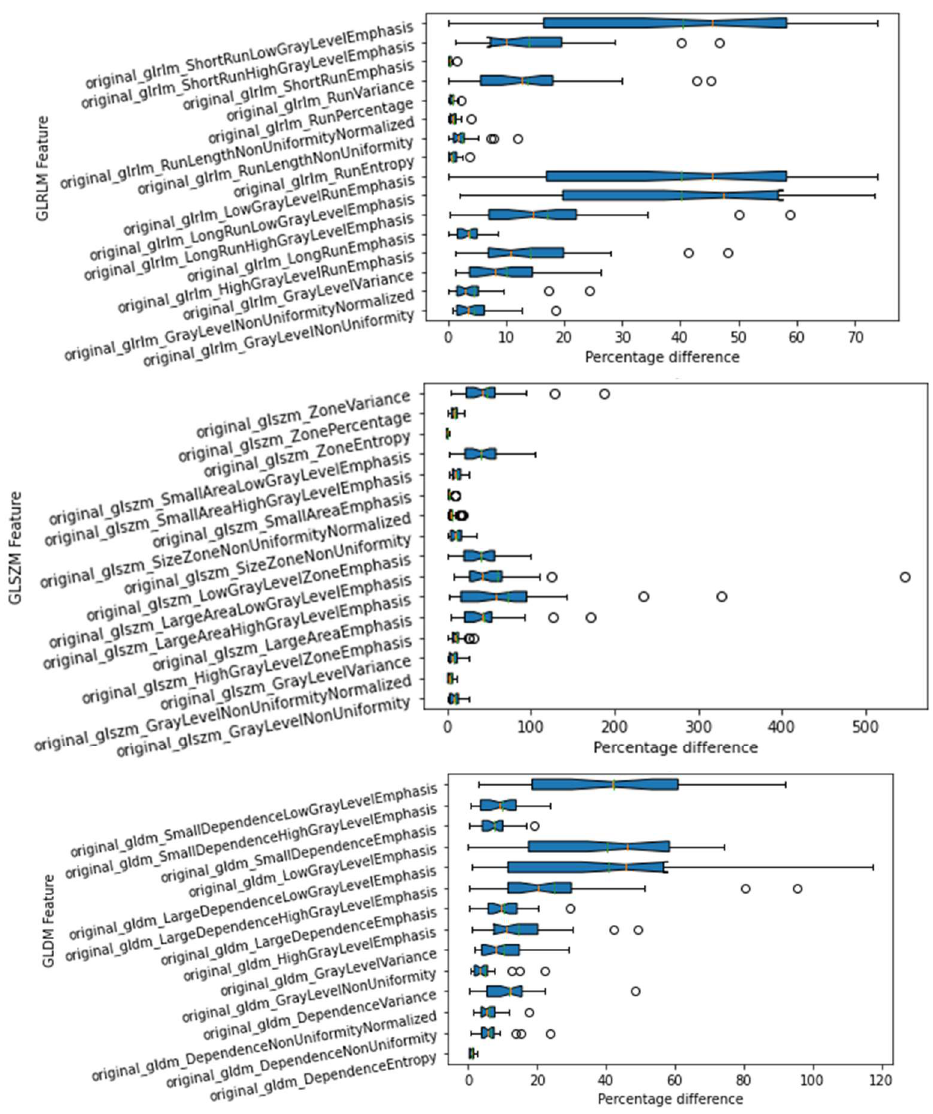
Figure 4. Difference percentage between non-co-registered and co-registered PET with T1-weighted and FLAIR MRI (the median is indicated in orange, while mean in green) for GLRLM, GLSZM, and GLDM features.